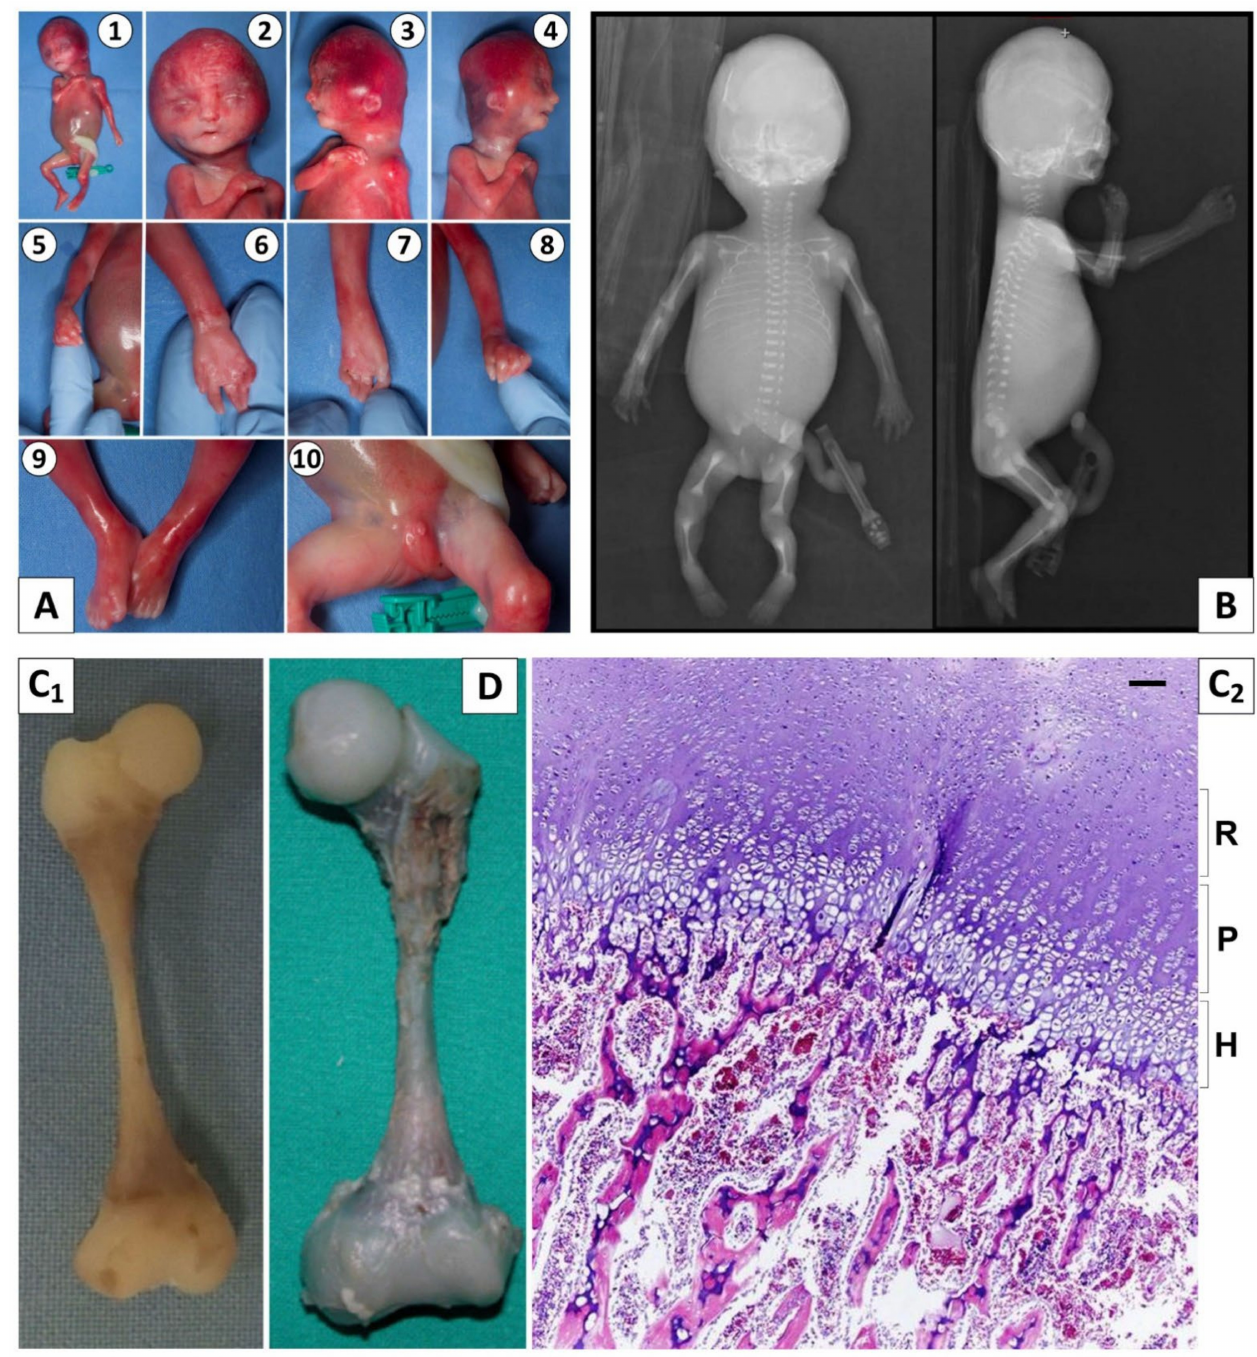
Figure 1. Clinical case #1. ( A1 – 4 ) Frontal bossing, bitemporal narrowing with supra-auricular bulging and parietal bossing, short palpebral fissures, hypertelorism, narrow mouth, low-set ears. ( A5 – 8 ) Camptodactyly of proximal interphalangeal joints of the 2nd–5th fingers. ( A9 ) Bilateral short hallux. ( A10 ) Micropenis. ( B ) Babygram X-rays: underossification of the skull, 11 pairs of thin ribs, mild platyspondyly, mild irregular cervical vertebrae, thin long bones with increased density, metaphyseal flaring and with obliteration of the medullary cavity. ( C , D ) Pathological examination of femur: ( C1 ) macroscopically, the femur had a thin diaphysis with splayed metaphyses, and appeared similar to the picture ( D ) originally presented by Unger et al. [7]. ( C2 ) Histological examination: architecture of the growth plate of the proximal femur showing a normal resting cartilage (R), a rarefied proliferating zone (P) and narrow cartilage lacunae in the hypertrophic zone (H). Scale bar = 25 µ